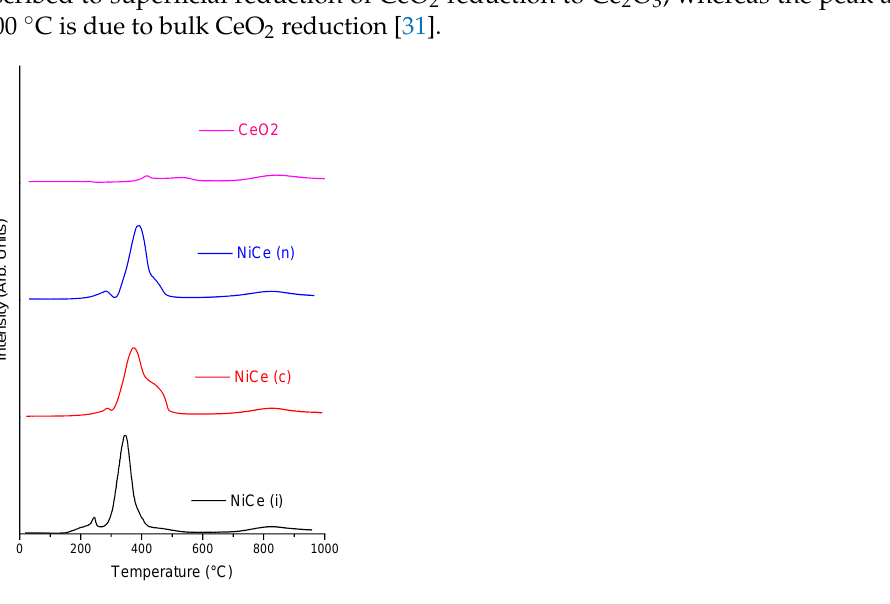
Figure 4. XRD spectra of the catalysts. 3.2. Catalytic Tests As previously stated, MDR is a promising endothermic process for syngas produc- tion from biogas [33]. For these reasons, the reactions tests were carried out at 700 °C for 30 h with a GHSV of 12,000 h −1 . Moreover, for each system, conversions of CH 4 , CO 2 and H 2 /CO have been calculated. A variation in this ratio can be ascribed to progressive cata- lyst deactivation [34].